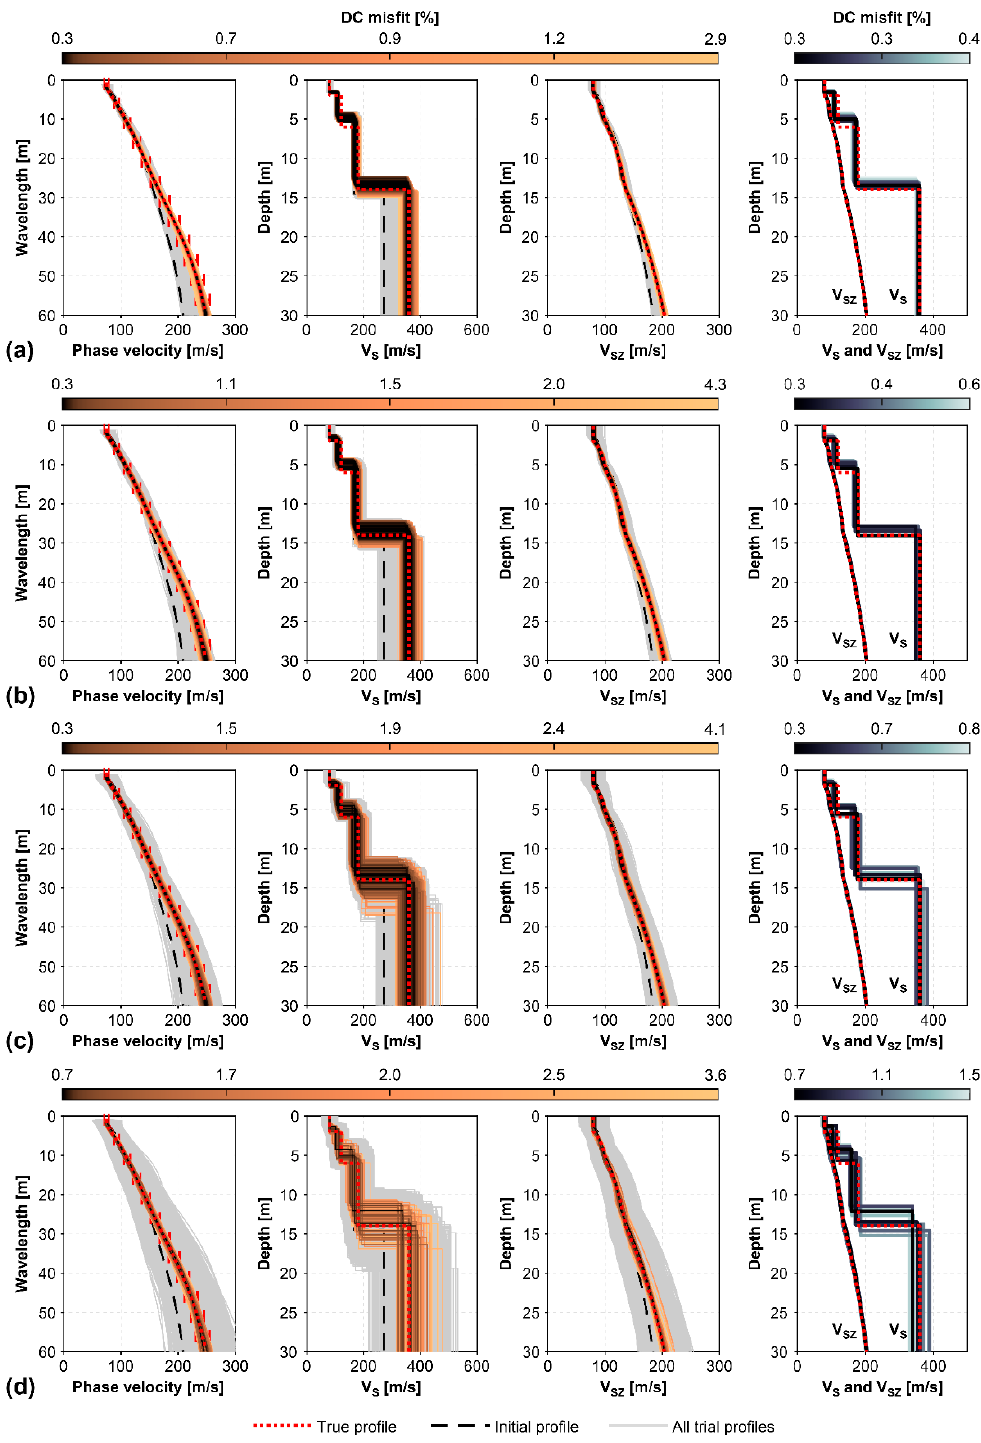
Figure 9. Inversion of the unperturbed synthetic dispersion curve from model B. A geologic structure consisting of four layers (incl. the half-space) was assumed. The search-control parameters were specified as ( a ) b = 2.5, ( b ) b = 5, ( c ) b = 10 and ( d ) b = 20. Gray areas display all sampled models. Profiles whose dispersion curves deviate less than 5% from the synthetic curve at all wavelengths are shown using a color scale defined based on dispersion misfit values. The lowest DC misfit V S - and V SZ -profiles within each independent set of 1000 iterations are shown in the column furthest to right.